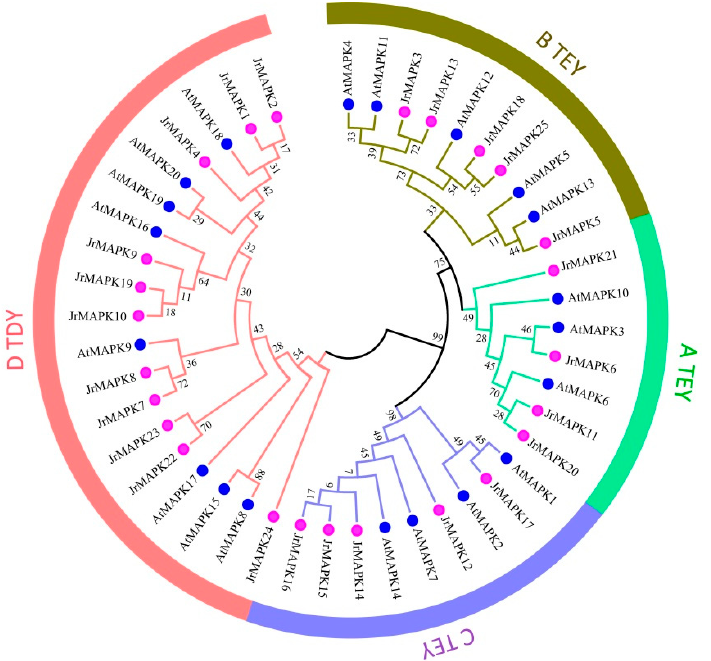
Figure 2. Evolutionary analysis and group classification of the AtMAPK ( Arabidopsis thaliana ) and JrMAPK ( Juglans regia ) proteins. The neighbor-joining (NJ) method in MEGA5.0 was used to construct the phylogenetic tree. Bootstrap values from 1000 replicates are displayed at each node. A-D indicate the different groups of MAPKs.